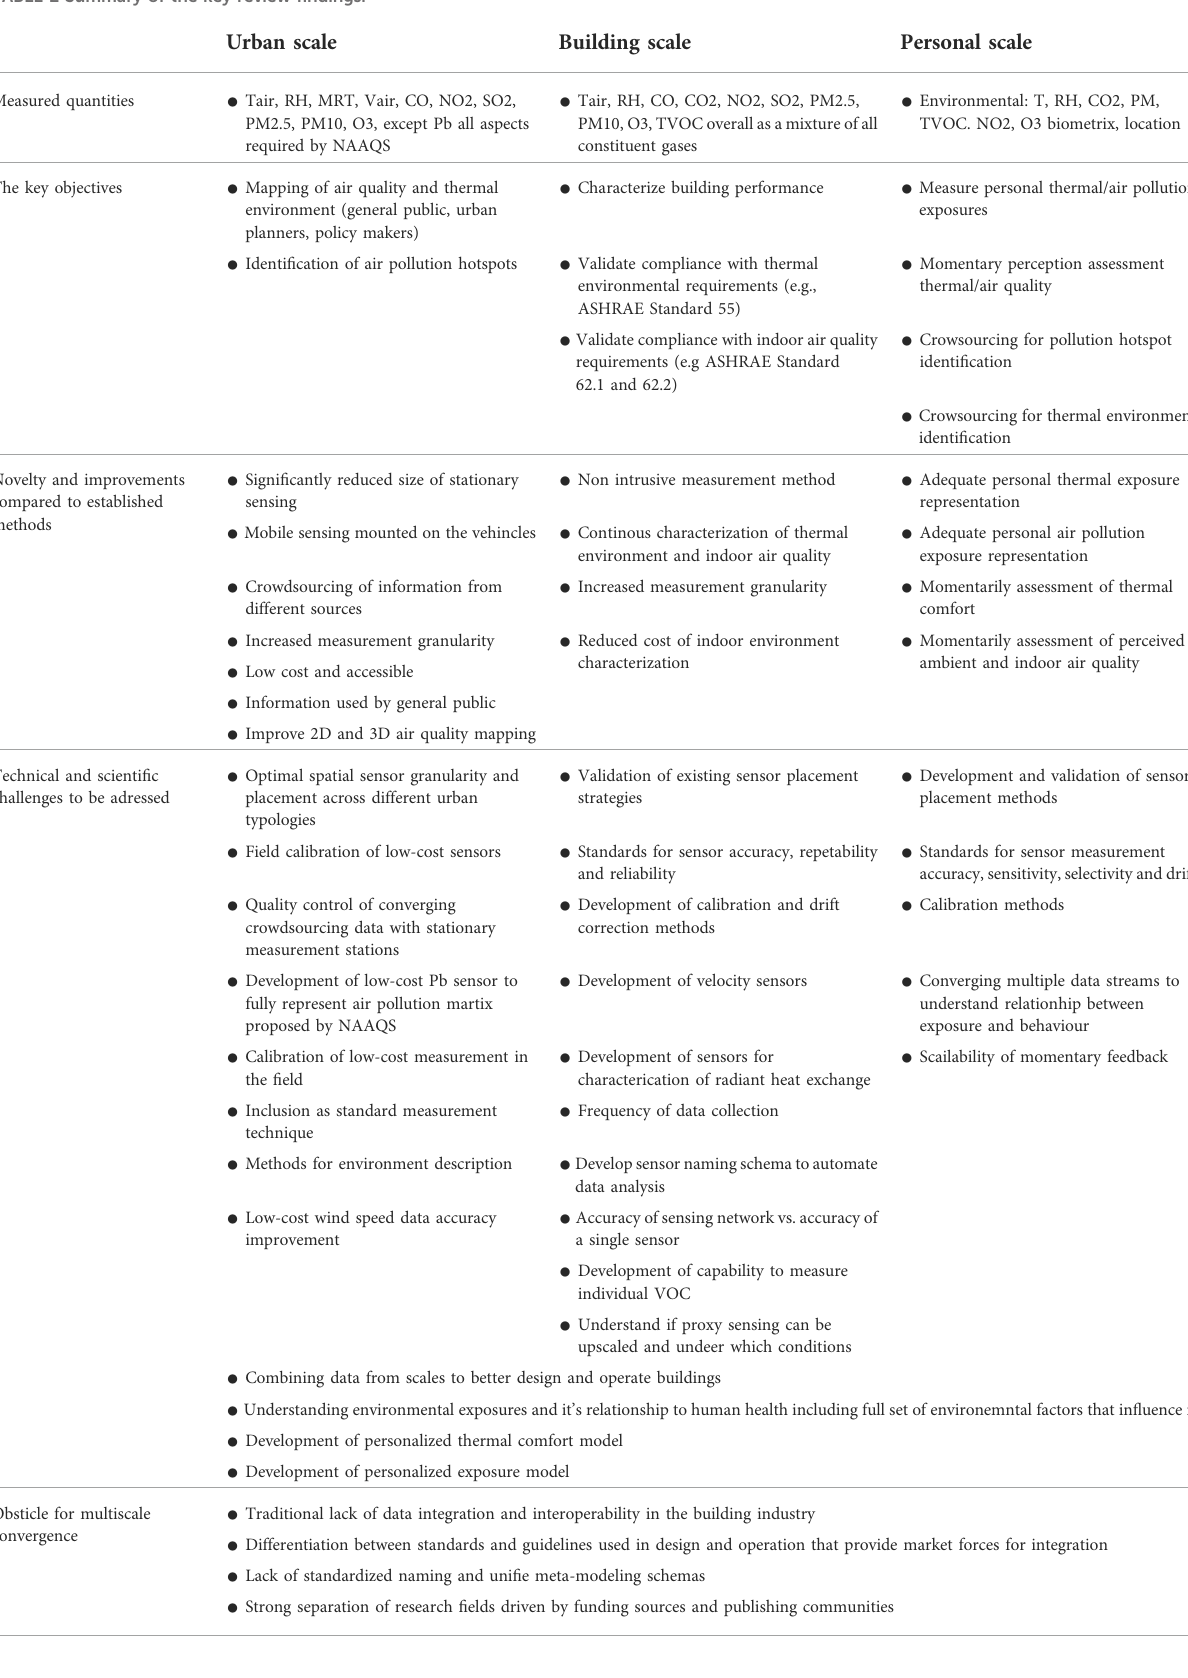
TABLE 2 Summary of the key review fi